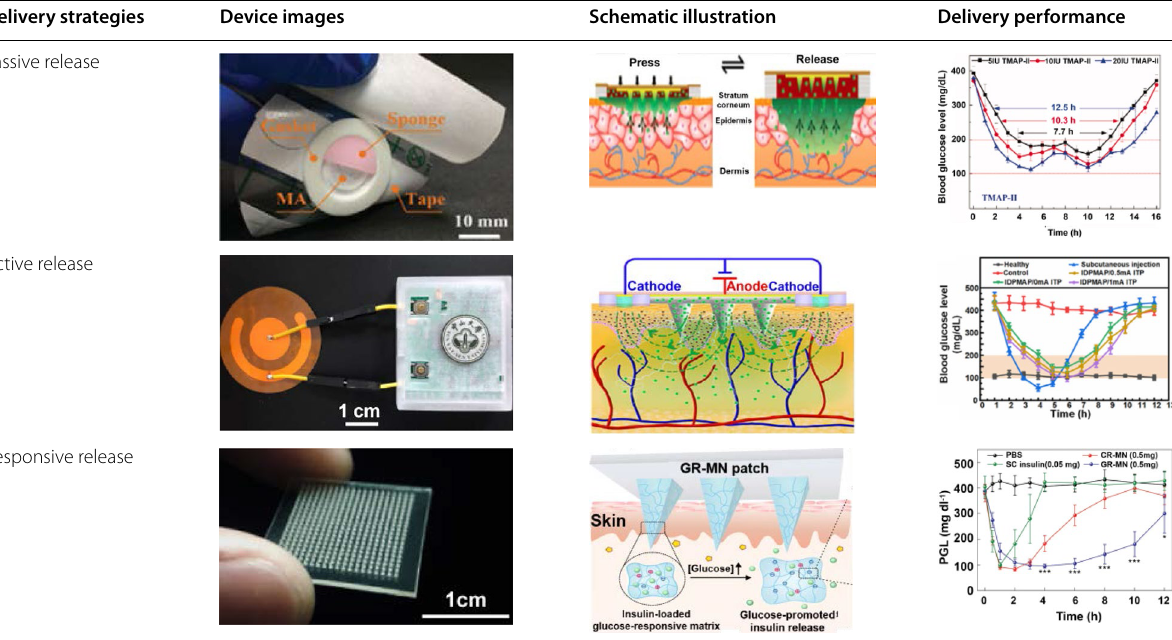
Table 9 Transdermal drug delivery of microneedles Delivery strategies Device images Schematic illustration Delivery